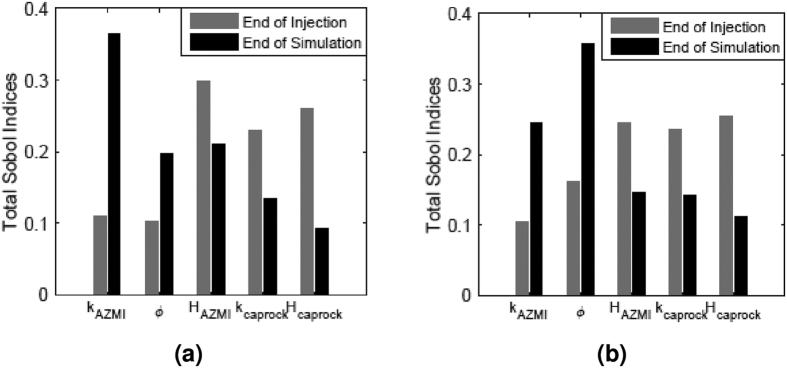
Sensitivity of AZMI ROM output for changes in pressure with respect to the uncertain parameters: AZMI permeability (kAZMI), AZMI porosity (ΦAZMI), thickness of AZMI (HAZMI), caprock permeability (kcaprock) and caprock thickness (Hcaprock) at: (a) above the injection well, i.e. coordinate (34, 46) and, (b) 4 km away from injection well southwards, i.e., coordinate (30, 44).